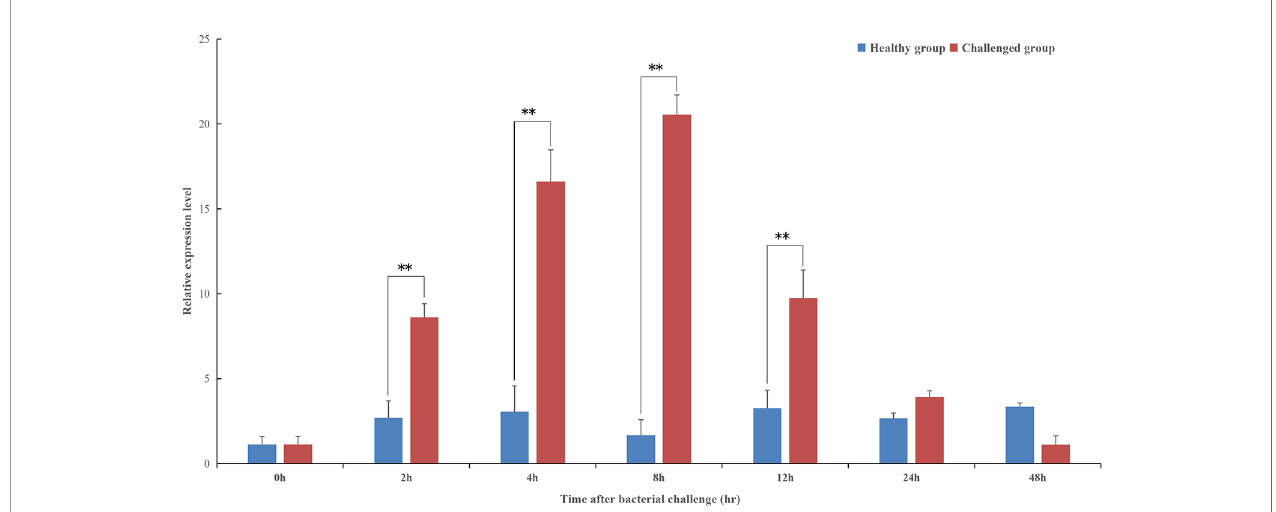
FIGURE 4 | The temporal expression pro fi les of pf-C3 in hemocytes of P. fucata challenged with V. alginolyticus were detected by Real-time PCR. Signi fi cant difference was indicated by asterisks, ** P < 0.01.